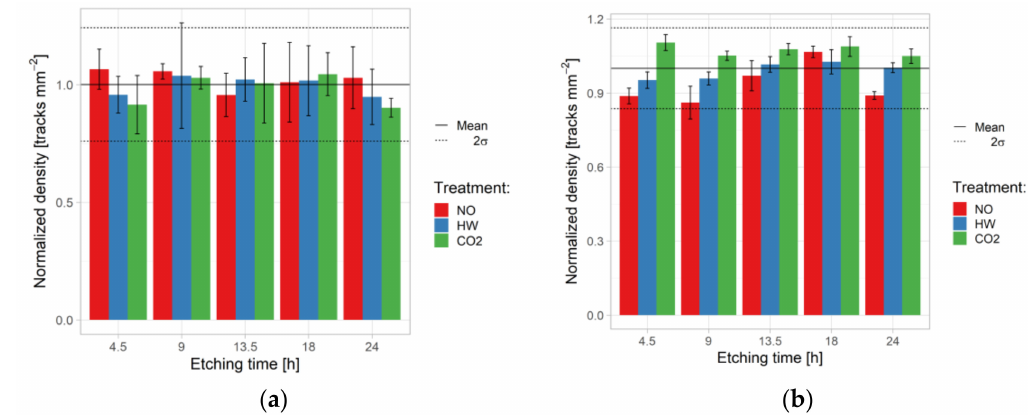
Figure 4. Track density vs. etching time for three pre-etching treatments in Experiment 2: 241 Am irradiation ( a ) and radon ( b ) exposures.